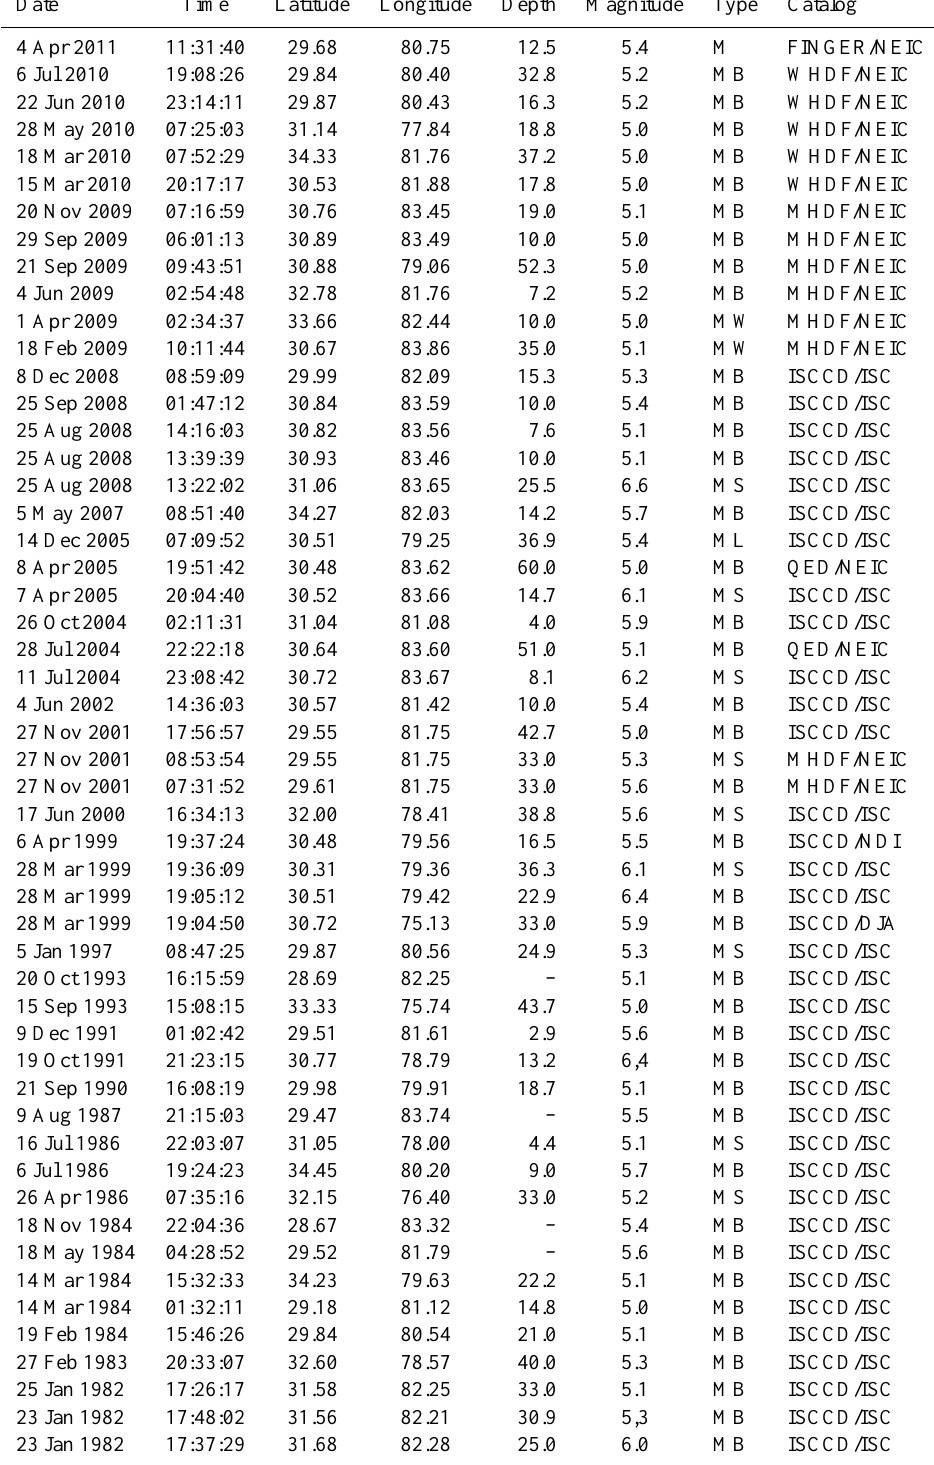
Table A2. List of earthquakes in the study area. Data provided by the Incorporated Research Institutions for Seismology (http://www.iris.washington.edu). Abbreviations of the magnitude types indicate the moment magnitude (MW), body-wave magnitude (MB), and surface-wave magnitude (MS). Abbreviations of the earthquake catalogues indicate the Bulletin of the International Seismological Centre (ISCCD), Quick Epicenter Determinations (QED), Monthly Hypocenter Data File (MHDF), Weekly Hypocenter Data File (WHDF), a list distributed by the National Earthquake Information Service (FINGER), and historical earthquake data listed in a hydropower project report (www.powermin.nic.in/whats new/PFR/HP/Luhri